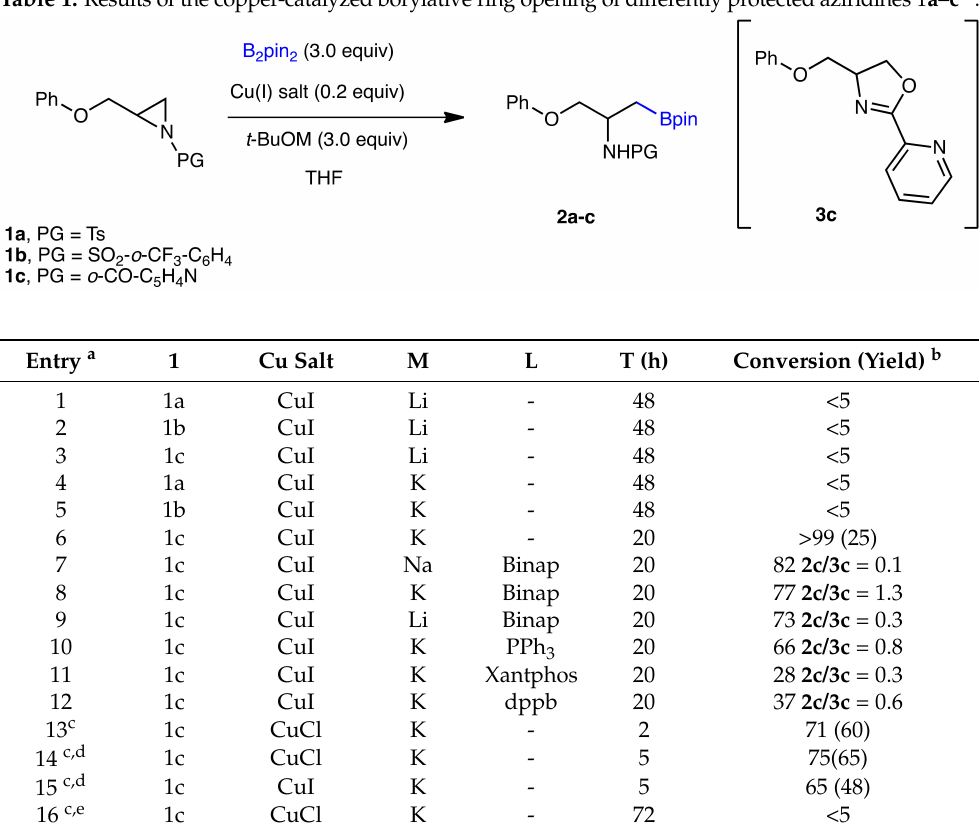
Table 1. Results of the copper-catalyzed borylative ring opening of differently protected aziridines 1 a – c a .